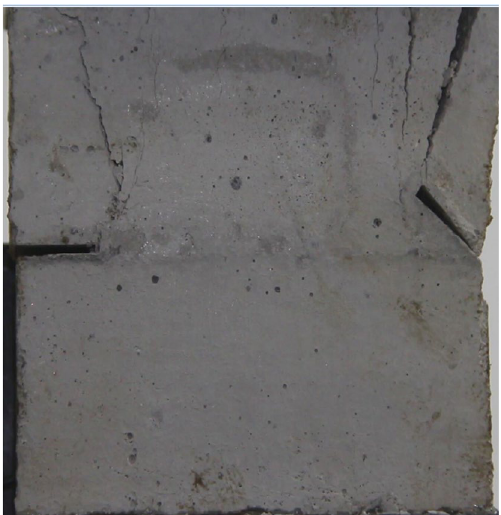
Figure 59. Photograph of a specimen showing tensile crack from the top surface caused by compression propagating.